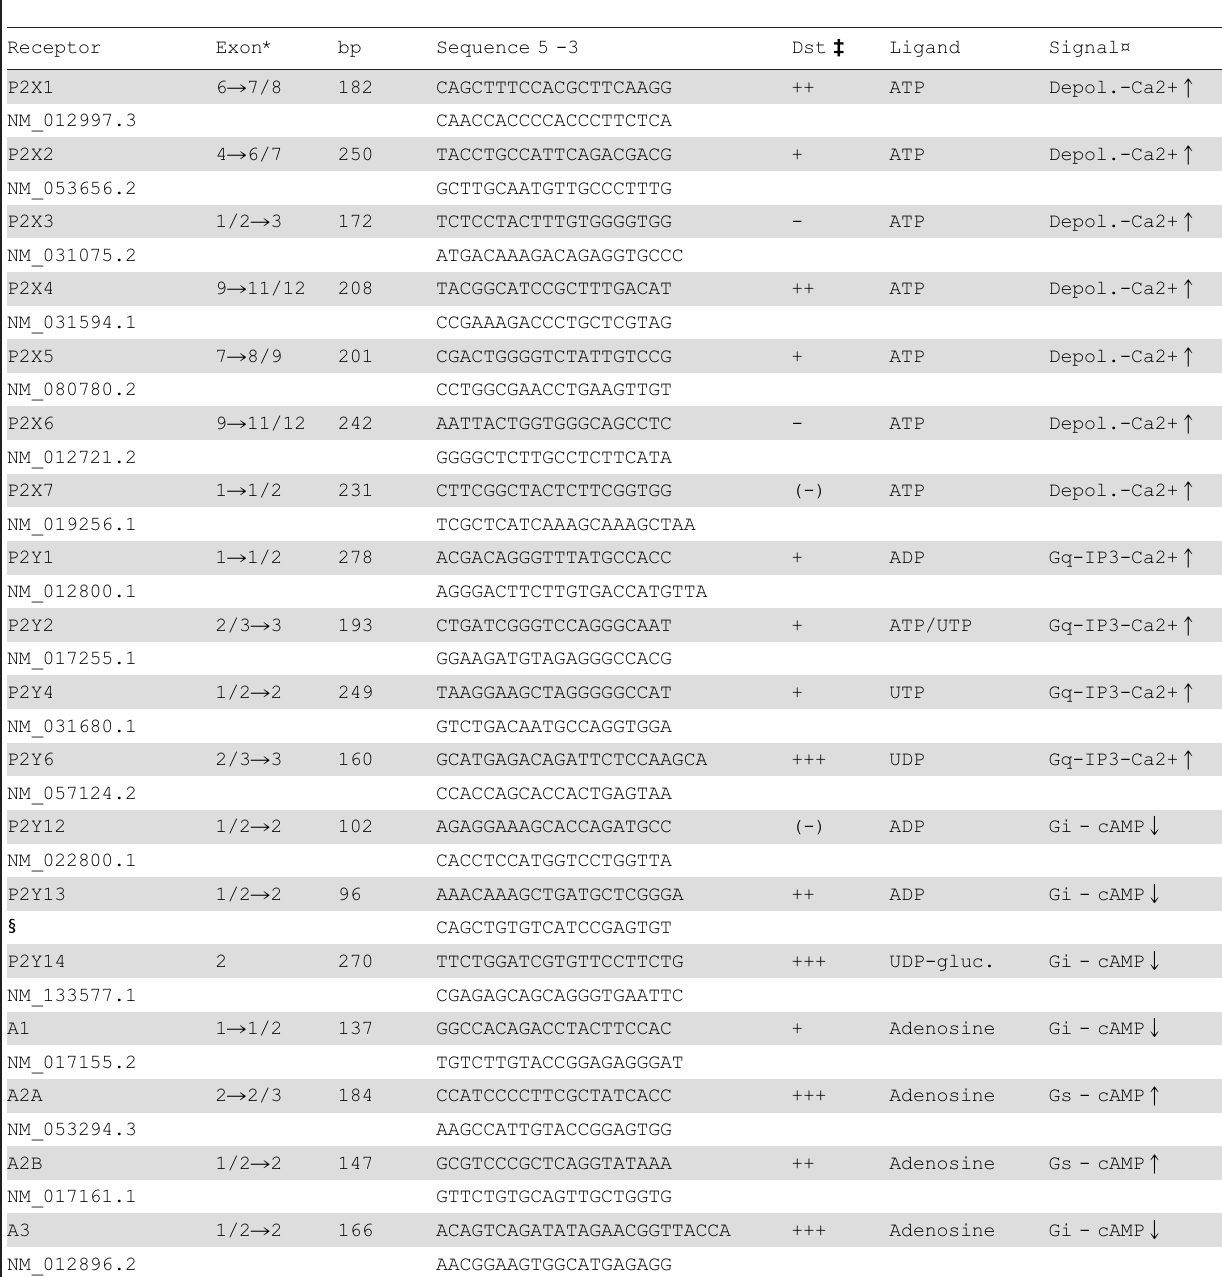
Table 1. Primers, distribution and intracellular pathways of purinergic receptors.